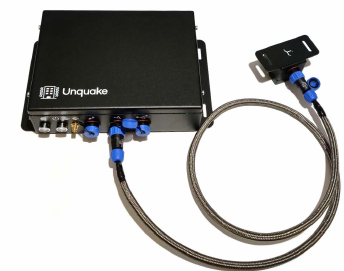
Figure 2. Unquake accelerograph.